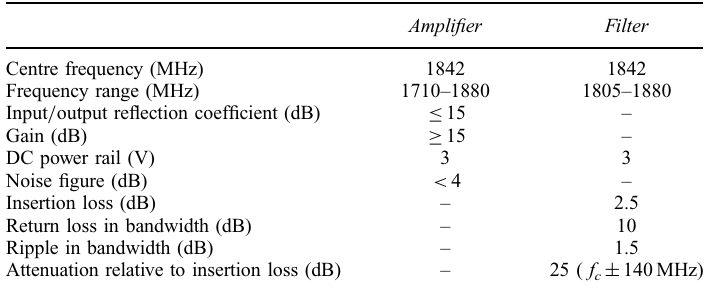
TABLE I Amplifier and Filter